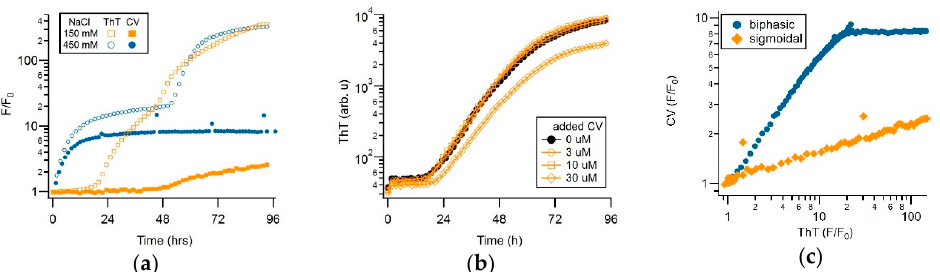
Figure 5. Crystal violet as the oligomer-selective dye (OSD). ( a ) Fractional change of 15 μ M ThT (open symbols) versus 5 μ M crystal violet (filled symbols) fluorescence during sigmoidal versus biphasic amyloid assembly (350 μ M hewL, pH 2, 52 °C) in the presence of either 150 or 400 mM NaCl). ( b ) ThT (15 μ M) kinetics of hewL undergoing sigmoidal fibril growth in the presence of increasing concentrations of CV. ( c ) Correlation of fractional CV versus ThT augmentation during biphasic versus sigmoidal growth. During the oligomer-dominated phase of biphasic kinetics, fractional changes of CV and ThT fluorescence are in a lock step and are of comparable magnitude. In contrast, CV becomes essentially unresponsive to the second, fibril-dominated phase. During sigmoidal fibril growth, CV barely increases 1.5-fold, compared to the nearly 100-fold fluorescence increase of ThT. Upon aligning the (noise-limited) CV traces with the upswing in ThT, their responses are strictly linearly correlated in time.